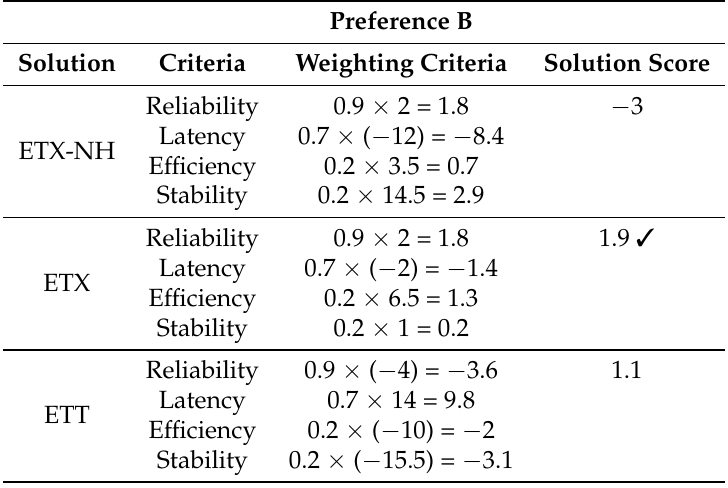
Table 7. Solution scores after weighting for preference